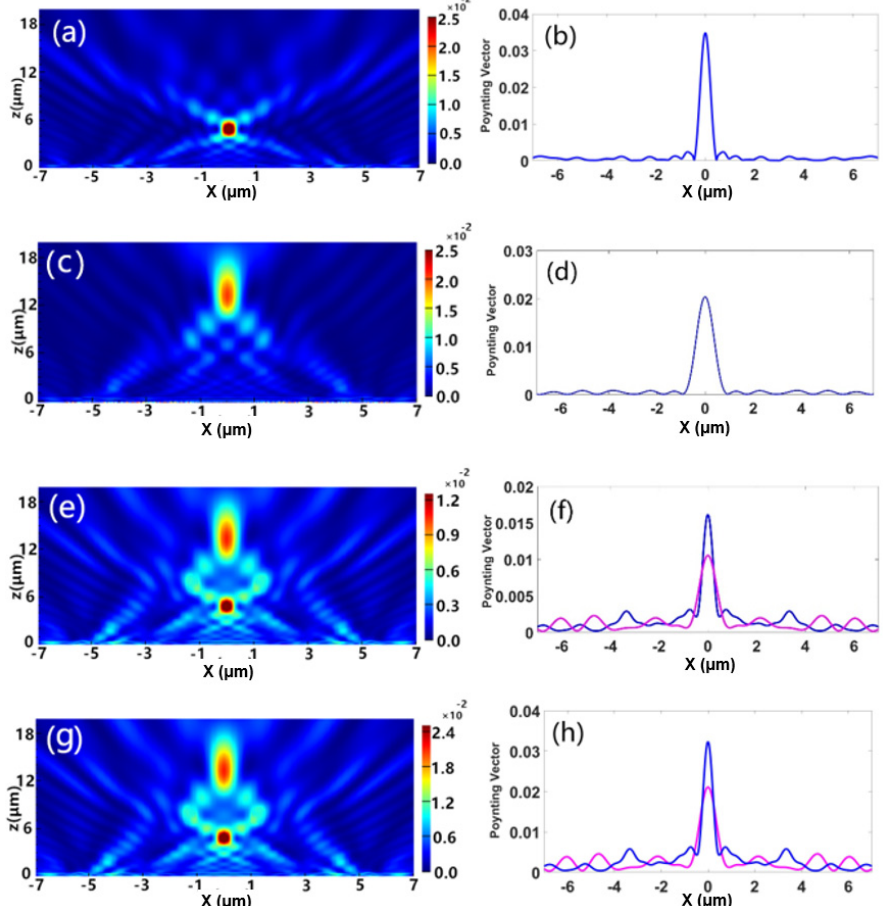
Figure 5. ( a ) The Poynting vector of the reflected light fields for the metalens with x- polarized incidence; ( b ) the intensities of the focusing spots along the x-direction for x- polarized incidence; ( c ) the Poynting vector of the reflected light fields for the metalens with y-polarized incidence; ( d ) the intensities of the focusing spots along the x-direction for y-polarized incidences; ( e ) the Poynting vector of the reflected light fields for the metalens with 45-degree linearly polarized incidence; ( f ) the intensities of the focusing spots along the x-direction for 45-degree linearly polarized incidence; ( g ) the Poynting vector of the reflected light fields for the metalens with circularly polarized incidence; ( h ) the intensities of the focusing spots along the x-direction for circularly polarized incidence.